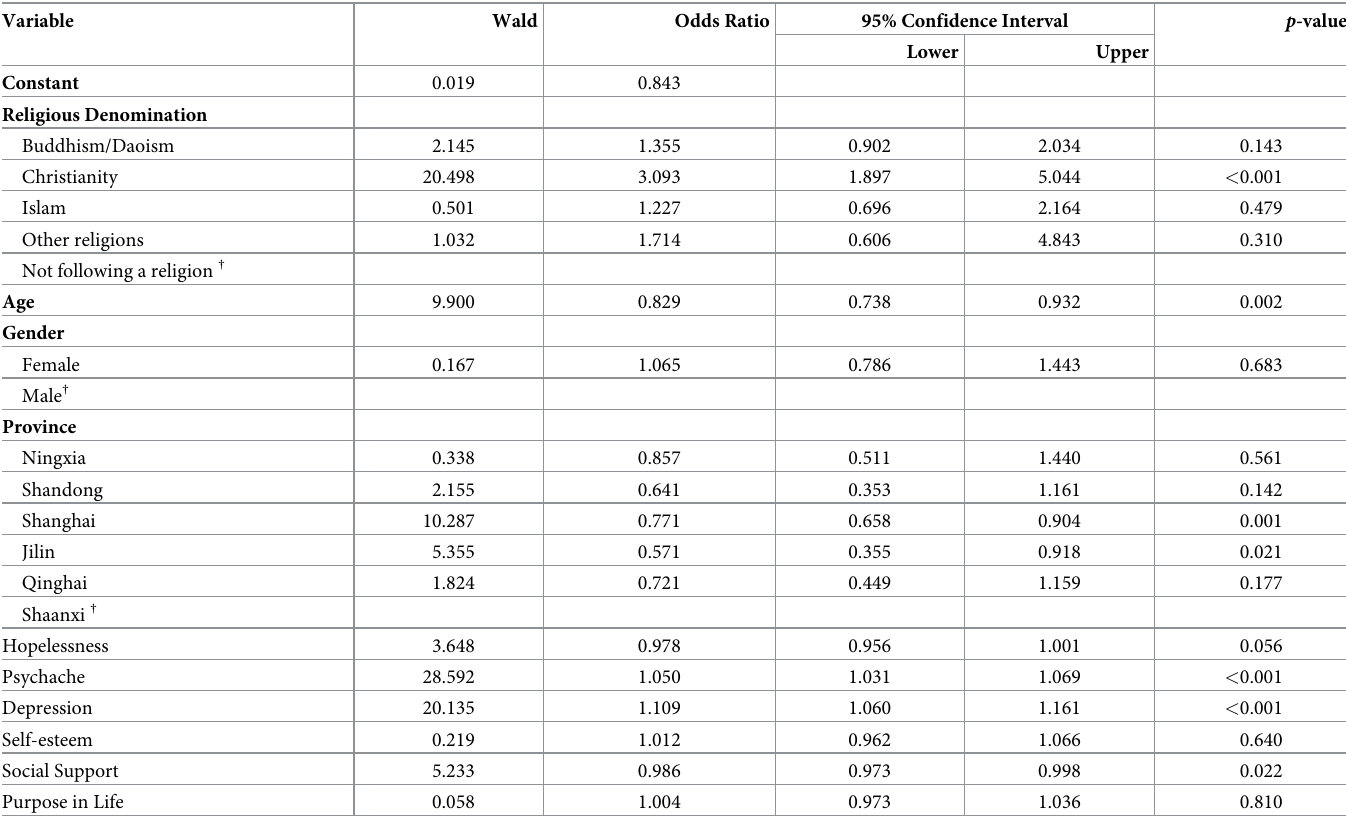
Table 5. Multiple logistic regression analysis for factors predicting suicide attempt among college